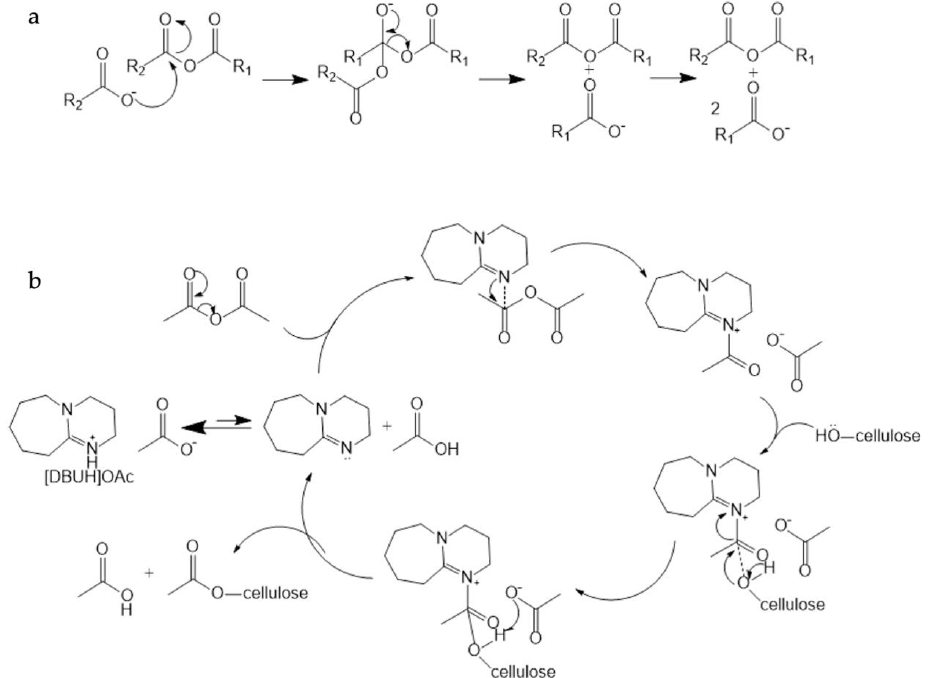
Figure 7. Mechanisms of acetylation of cellulose in [DBUH]OAc ( a ) and the generation of carboxylic anhydride from the carboxylate anion and Ac 2 O ( b ) (reprinted with permission from [80]. Copyright © 2018, Royal Society of Chemistry).